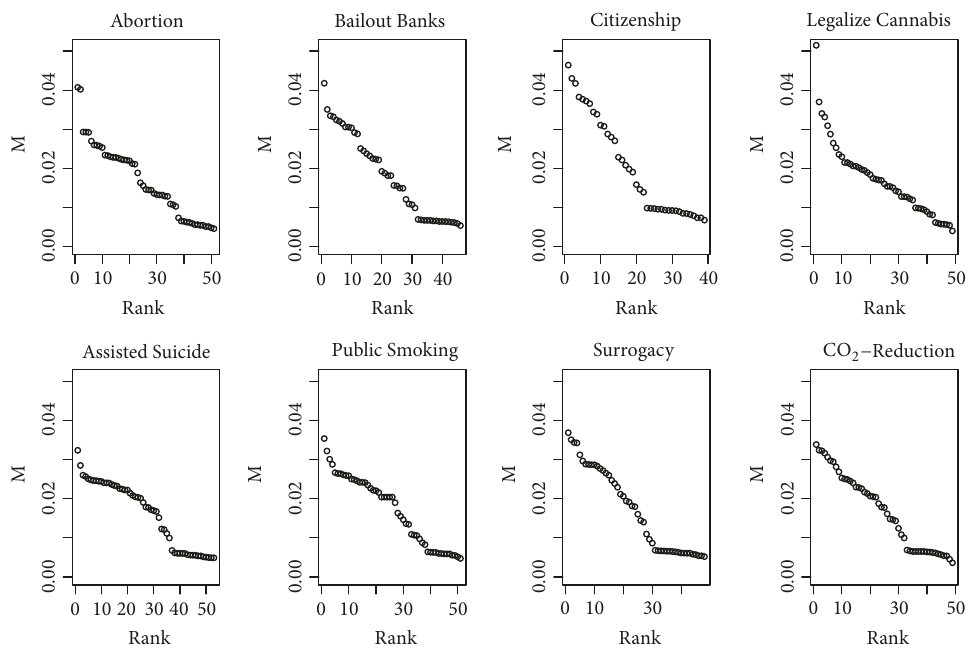
Figure 10: Participants’ mediation centrality, ranked from largest to smallest, for each of the eight policy issues.